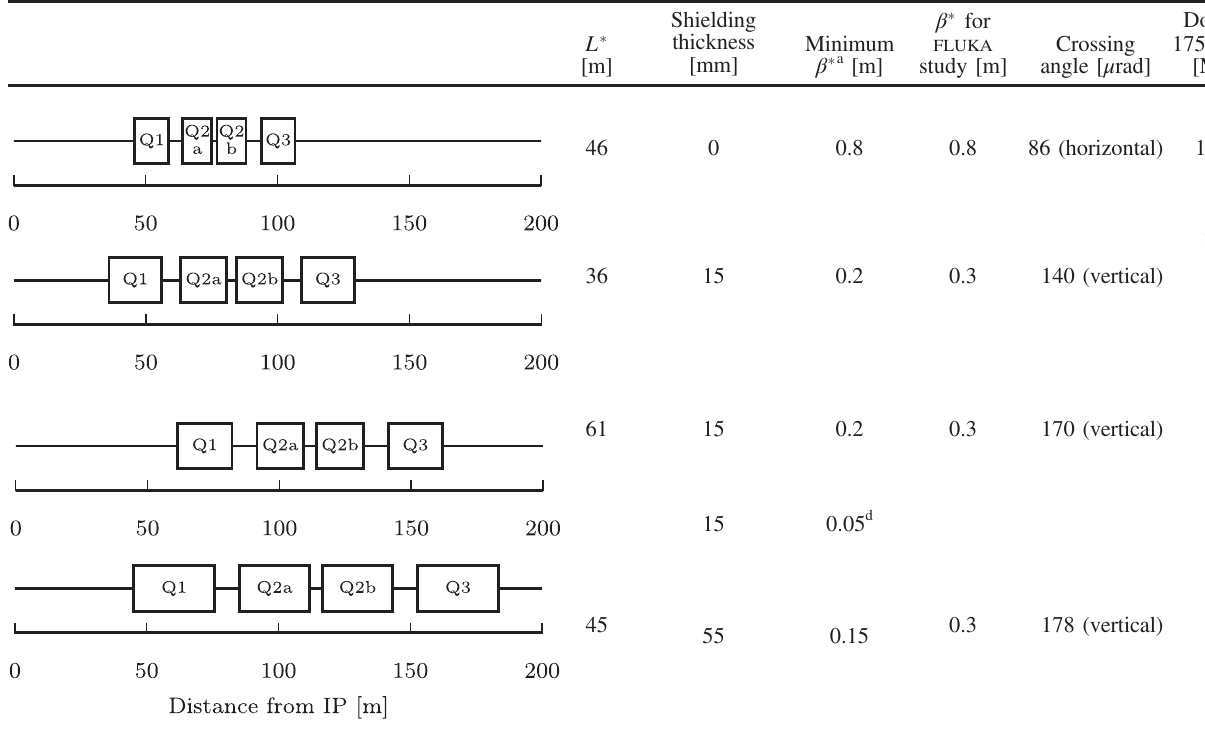
INTERACTION REGION DESIGN DRIVEN TABLE VI. Summary of the presented triplet options. The shielding thickness defines the minimum β (cid:2) . The β (cid:2) used for FLUKA studies was set to the ultimate goal where possible and mainly impacts the dose via the crossing angle.